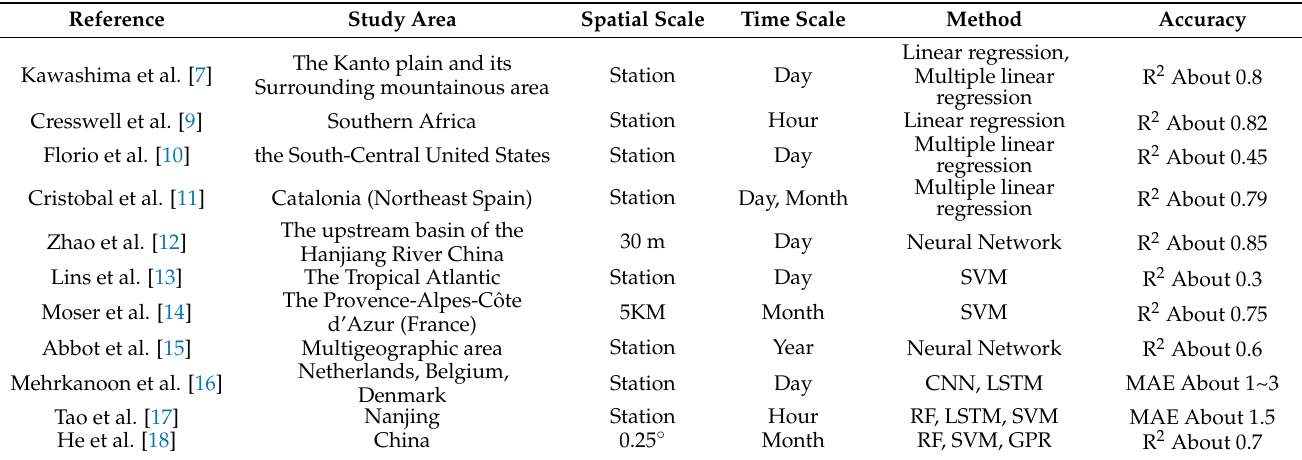
Table 1. Some previous research work for